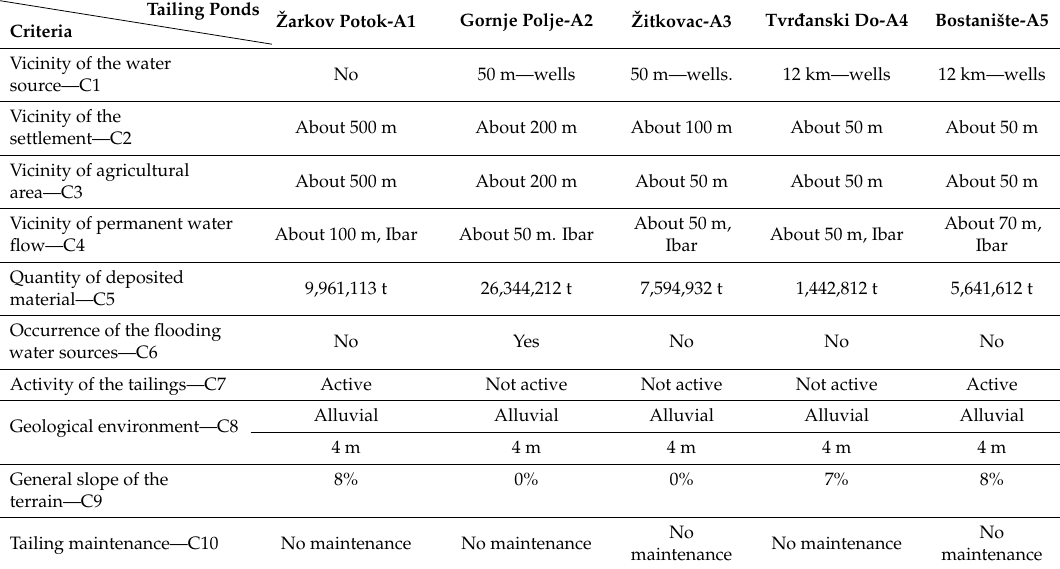
Table 1. The characteristics of the analyzed flotation tailing